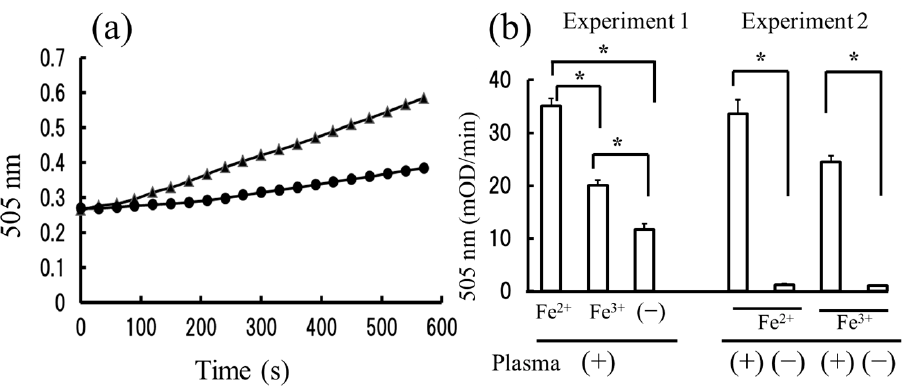
Figure 1. The effect of iron ions on the measurement of reactive oxygen metabolites. ( a ) Time courses of absorbance changes at 505 nm after the addition of plasma from a healthy subject and N , N ′ -diethyl- p -phenylenediamine were determined in the presence ( ▲ ) and absence ( ● ) of 100 µM Fe 2+ as described in the (Section 4); ( b ) Increased rate of absorbance (mOD/min) during 120 to 300 s was determined after the addition of N , N ′ -diethyl- p -phenylenediamine, and iron ions (Fe 2+ or Fe 3+ ) in the presence of plasma (Experiment 1) or in the presence or absence of plasma (Experiment 2). The results are expressed as the mean ± standard deviation ( n = 5). A symbol (*) represents a statistically significant difference ( p < 0.001). When the plasma samples from two other healthy subjects were used, similar effects of Fe ions were observed.